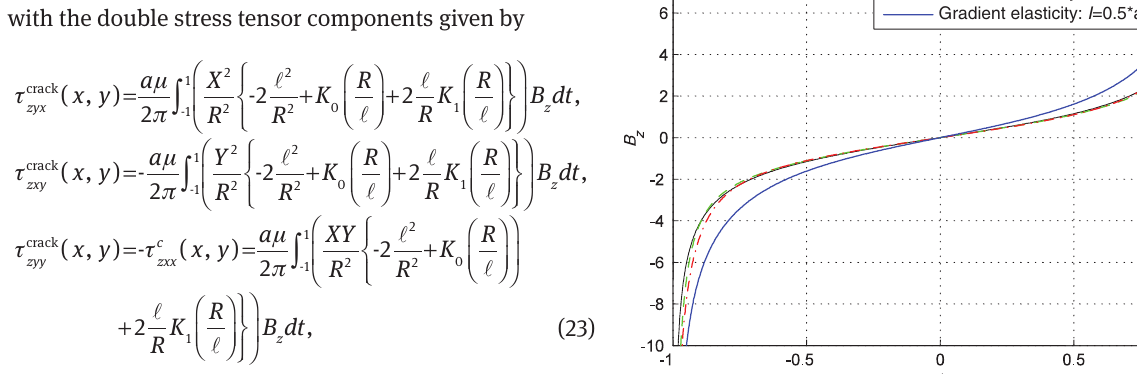
Classical elasticity Gradient elasticity: I =0.05*a